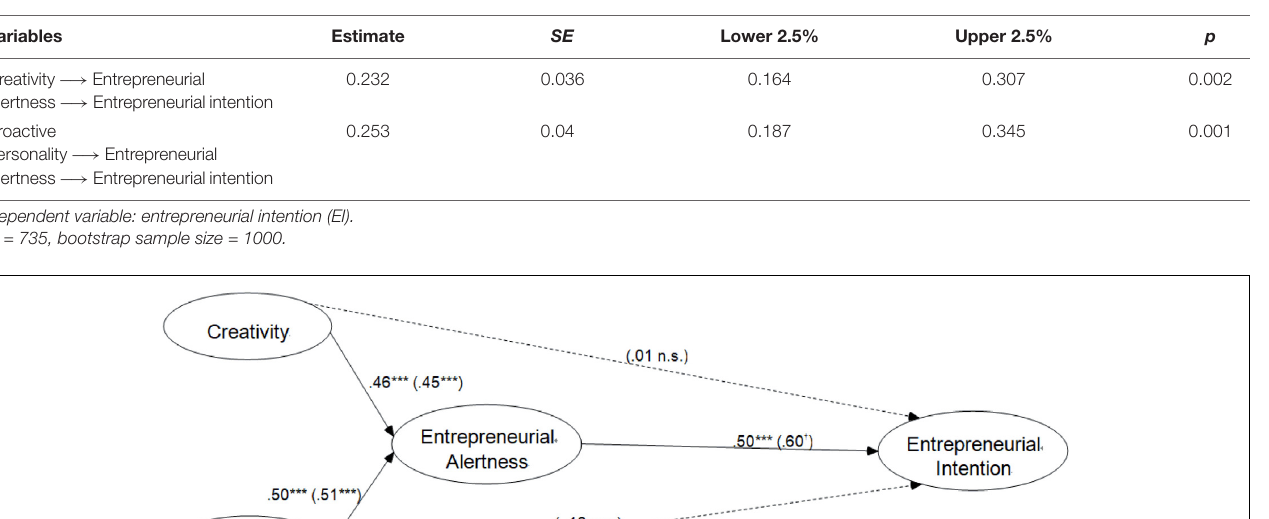
TABLE 3 | Bootstrapping regression results for creativity and proactive personality mediated by entrepreneurial alertness.